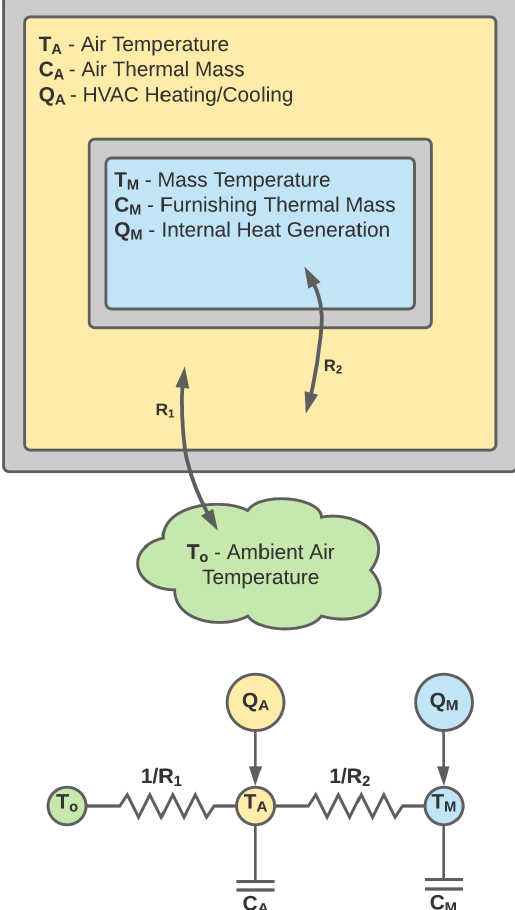
Figure 1. Second-order equivalent thermal parameter circuit